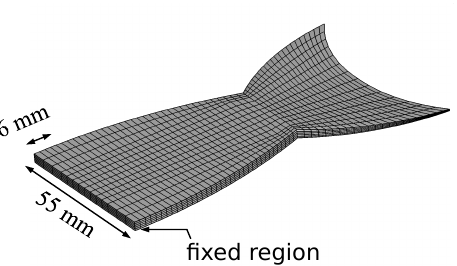
Figure 8. Finite element discretization and mechanical boundary conditions of the fish fin structure. The given values describe the region where mechanical constraints are